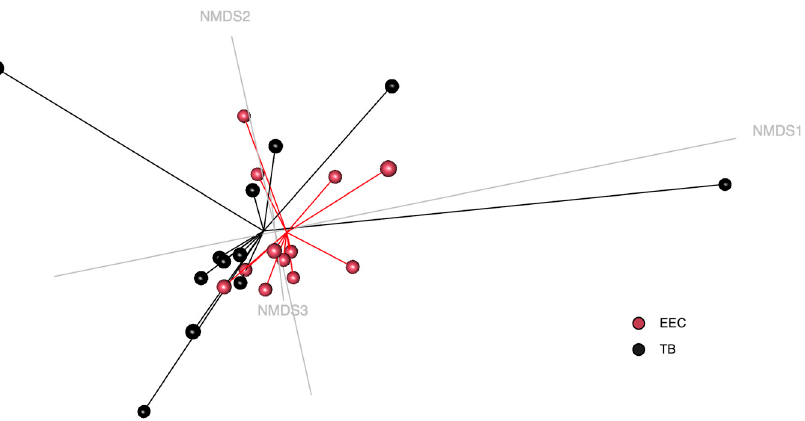
Figure 3. Non-metric multidimensional scaling (NMDS) ordination of external ear canal and tympanic bulla in 12 ears from 6 healthy Beagle dogs. No significant clustering was observed using AMOVA between the EEC and TB of experimental Beagle dogs. (Red dots, EEC; black dots, TB).